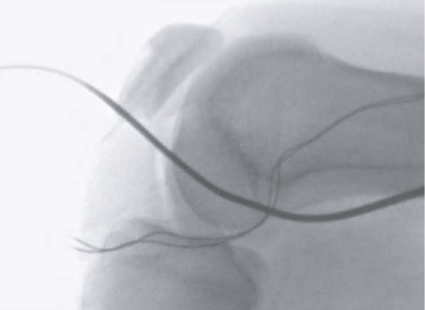
Figure 5: Intraoperative lateral fl uoroscopic image con fi rming the placement of the fl exible guide pin below the physis.